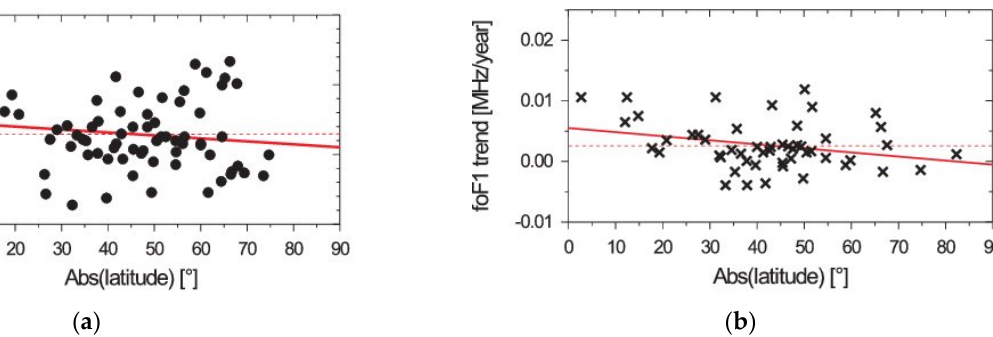
Figure 1. foE (dots) ( a ) and foF1 (x) ( b ) trends in terms of absolute value of the latitude of the individual stations. The dashed lines characterize the mean global foE and foF1 trends, the full lines are the curves of the best linear fit through the individual trend values. (Reproduced from Bremer [41]: Figures 6 and 10, modified).